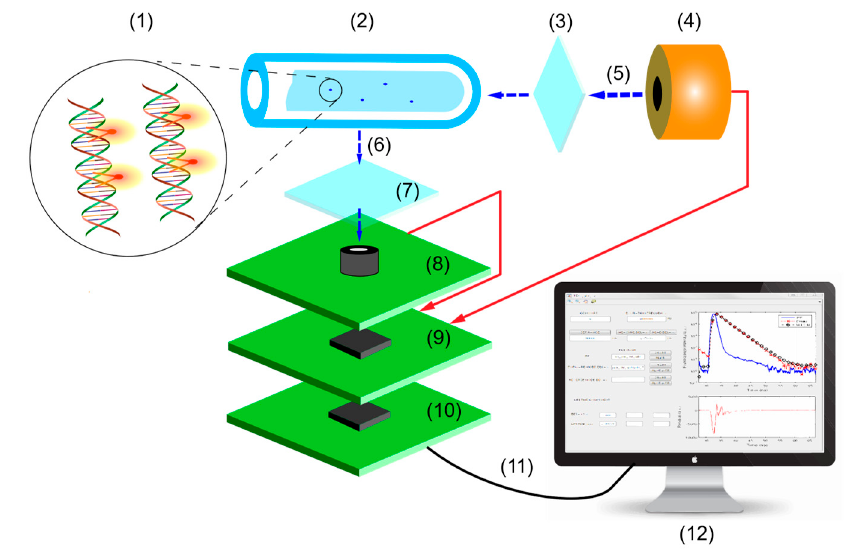
Figure 1. Schematic of the proposed time-correlated single photon-counting (TCSPC) system for DNA analysis. (1) DNA sample bound with fluorophores; (2) liquid-core waveguide (LCW); (3) thin-film neutral density (ND) filter; (4) excitation source; (5) excitation light; (6) emission light; (7) band-pass filter (optional); (8) photon acquisition; (9) time-to-digital conversion; (10) microcontroller unit (MCU); (11) USB connection; (12) data analysis and control.